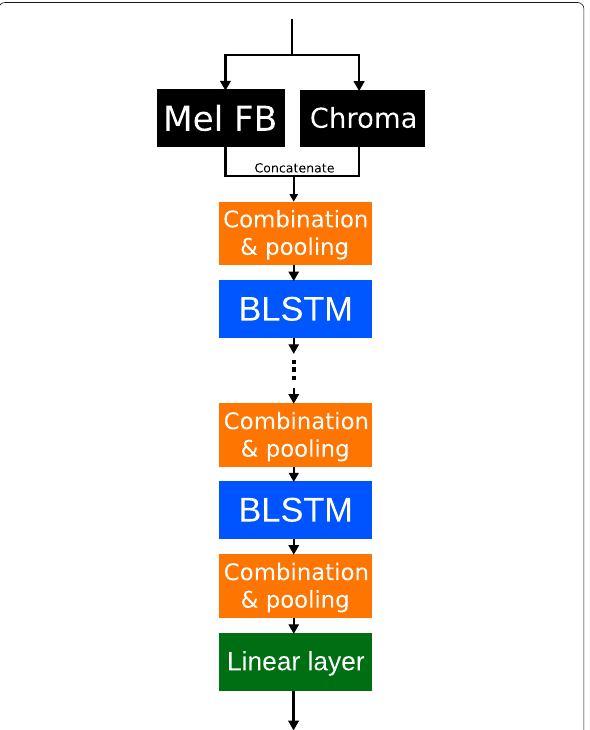
Fig. 3 Alternative BLSTM-based neural architectures including the proposed combination and pooling